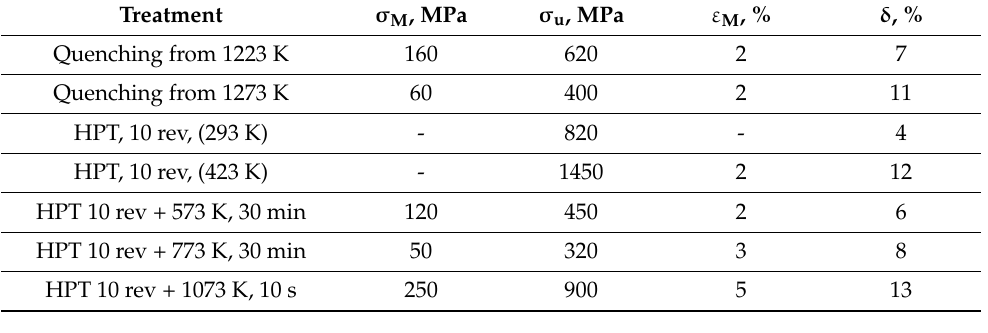
Table 6. Results of tensile mechanical tests of the Cu-14Al-3Ni alloy after different deformation– temperature treatments.